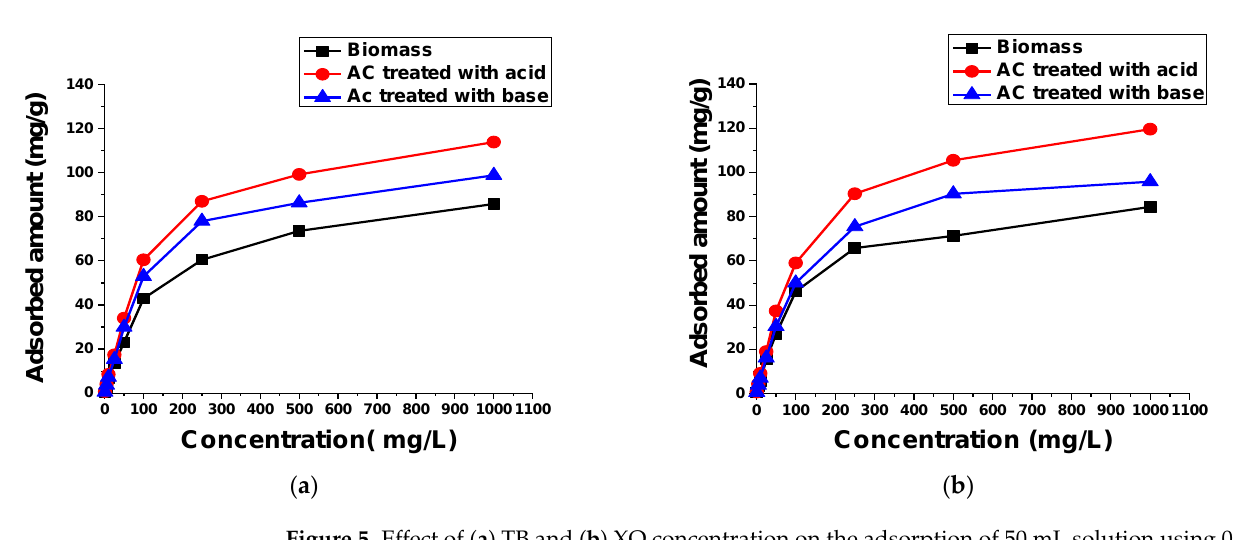
Figure 5. Effect of ( a ) TB and ( b ) XO concentration on the adsorption of 50 mL solution using 0.1 g biomass and AC treated with acid and base for 60 min at 140 rpm and room temperature. Table 3. Comparison of the adsorption of XO and TB of the current results with the previous literature.